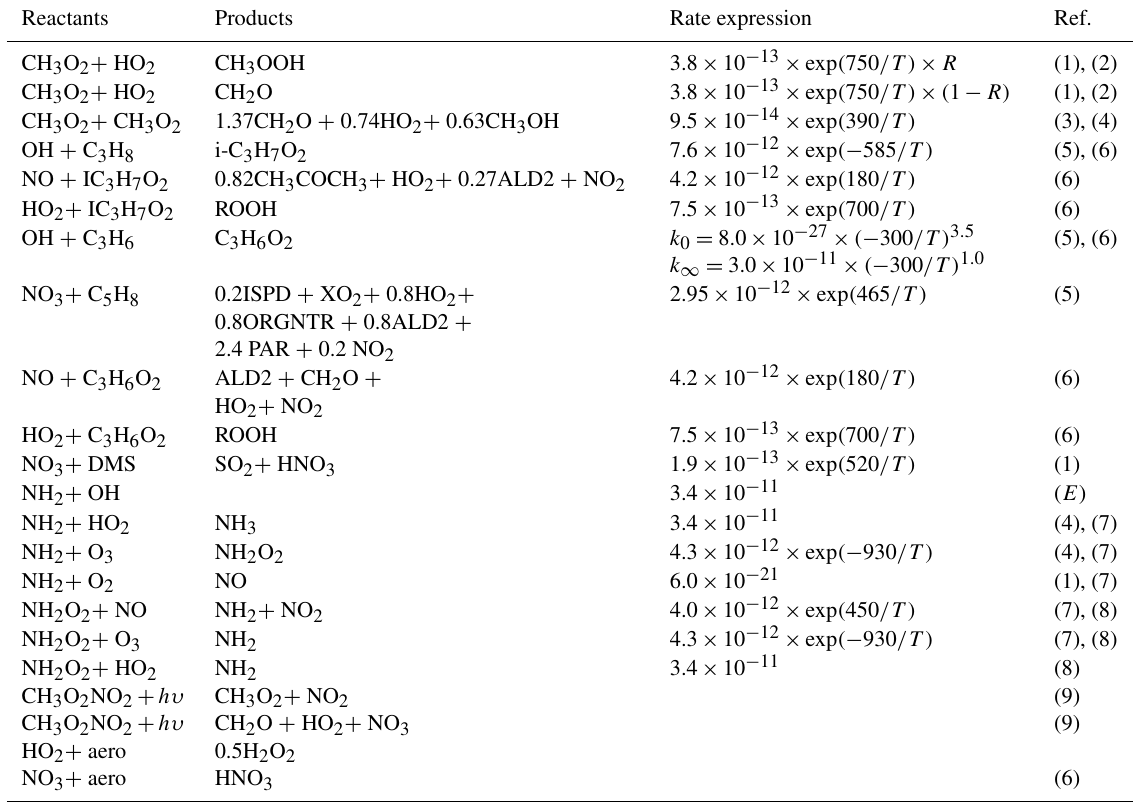
Table 2. Details of updates made to the reaction data and stoichiometry of the modified CB05 chemical mechanism for other reactions. Data are taken from the following: (1) Atkinson et al. (2004) accommodating the latest evaluation at http://iupac.pole-ether.fr, (2) a branching ratio ( R ) equal to 1 /( 1 + 498 . × exp ( − 1160 ./T ), (3) Yarwood et al. (2005), (4) Sander et al. (2011), (5) Atkinson et al. (2006), (6) Emmons et al. (2010), (7) Hauglustaine et al. (2014), (8) a rate assumed equal to the NH 2 analogue, (9) assumed to be equal to HNO 4 after Browne et al. (2011), and (10) E is an estimated